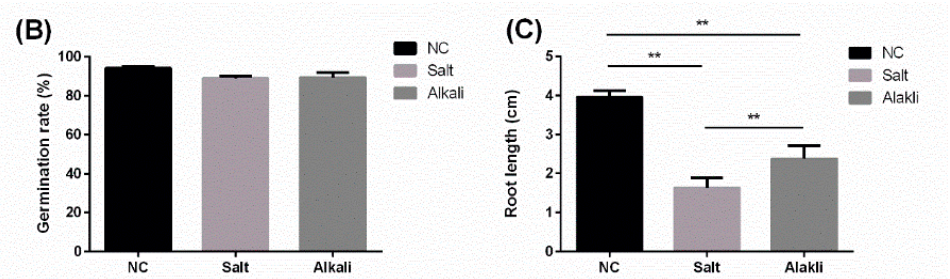
Figure 1. The germination characteristic of R108 in salt and alkali stress after 72 h. ( A ) The developmental profiles of germinated R108 in distilled water, salt treatment, alkali treatment, respectively; ( B , C ) The measurement of germination rate and seedling length in three treatments. **: p < 0.01. NC: non-specific control.